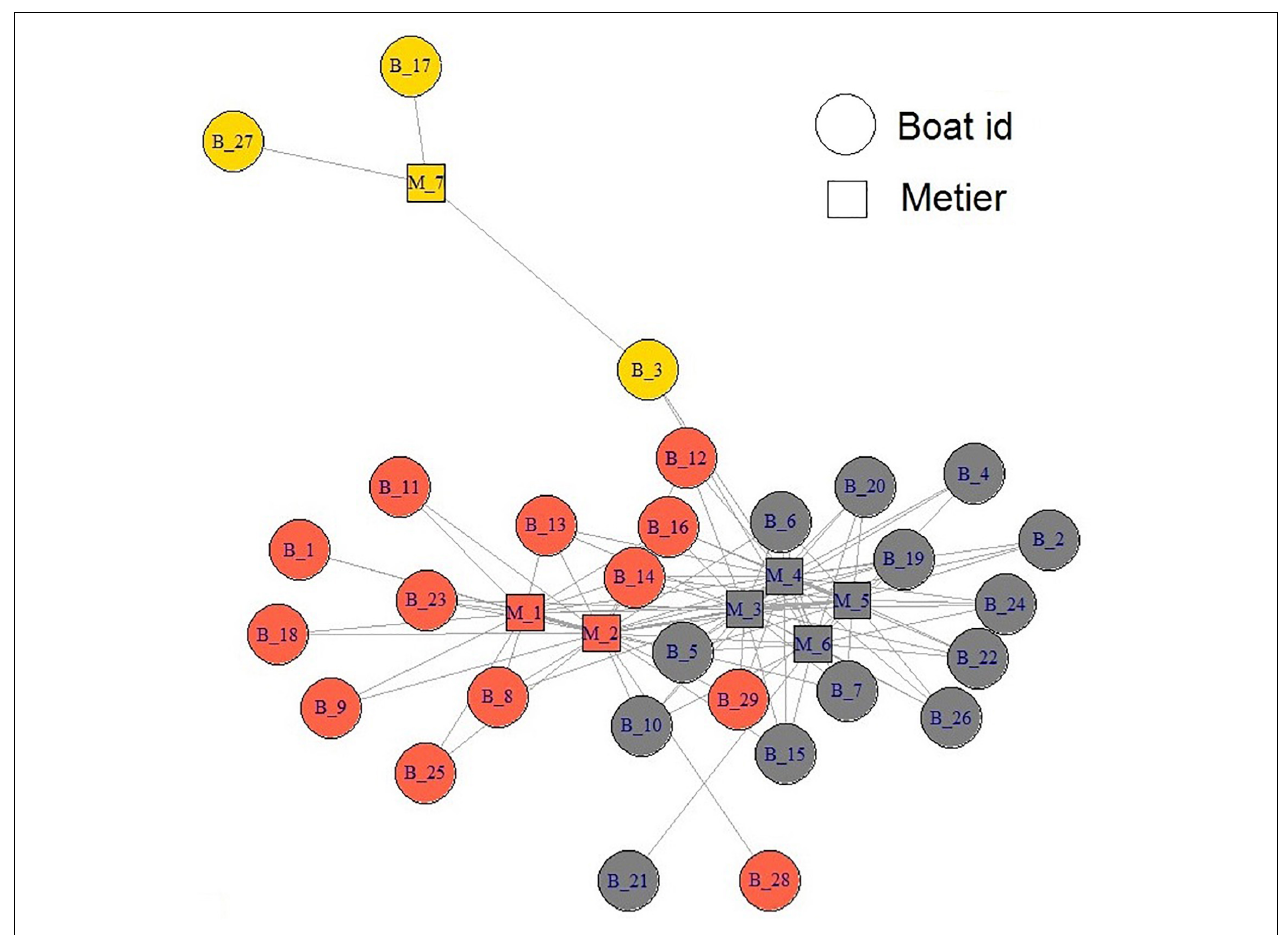
FIGURE 8 | Network of vessels and métier interaction in the Eastern Tuna and Billfish Fishery (ETBF). Circles represent individual vessels and the squares represent individual métiers. The color scheme represents a community of vessels